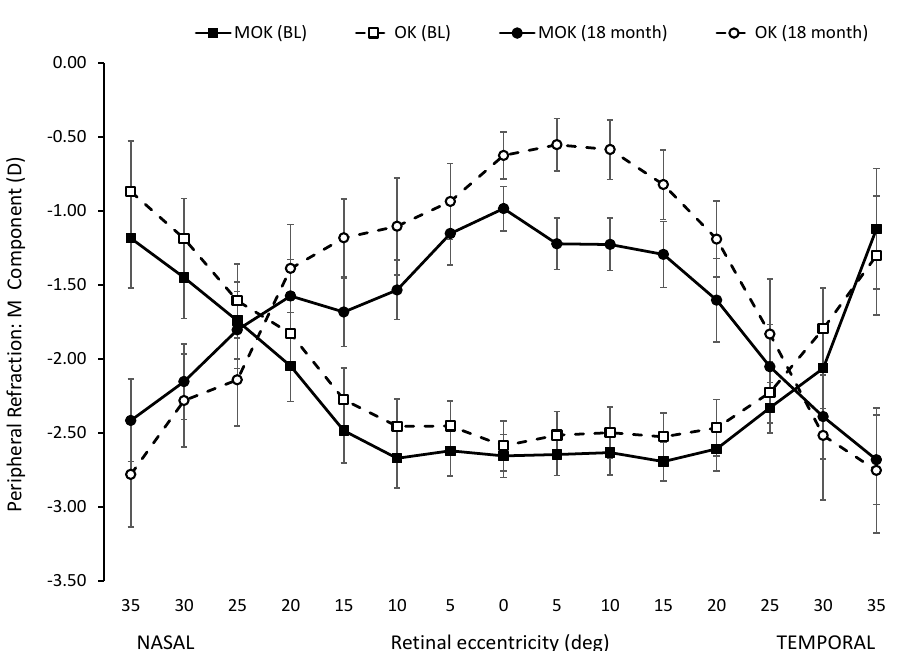
Figure A2. Tangential difference maps (18-month topography minus baseline topography). ( a ) Map for the MOK-treated eye with the greatest axial length increase over 18 months (+0.34 mm) and ( b ) map for the fellow OK-treated eye with an AL increase of +0.17 mm. ( c ) MOK-treated eye with the least axial length increase over 18 months ( − 0.48 mm) and ( d ) map for the fellow OK-treated eye with an AL increase of − 0.27 mm.